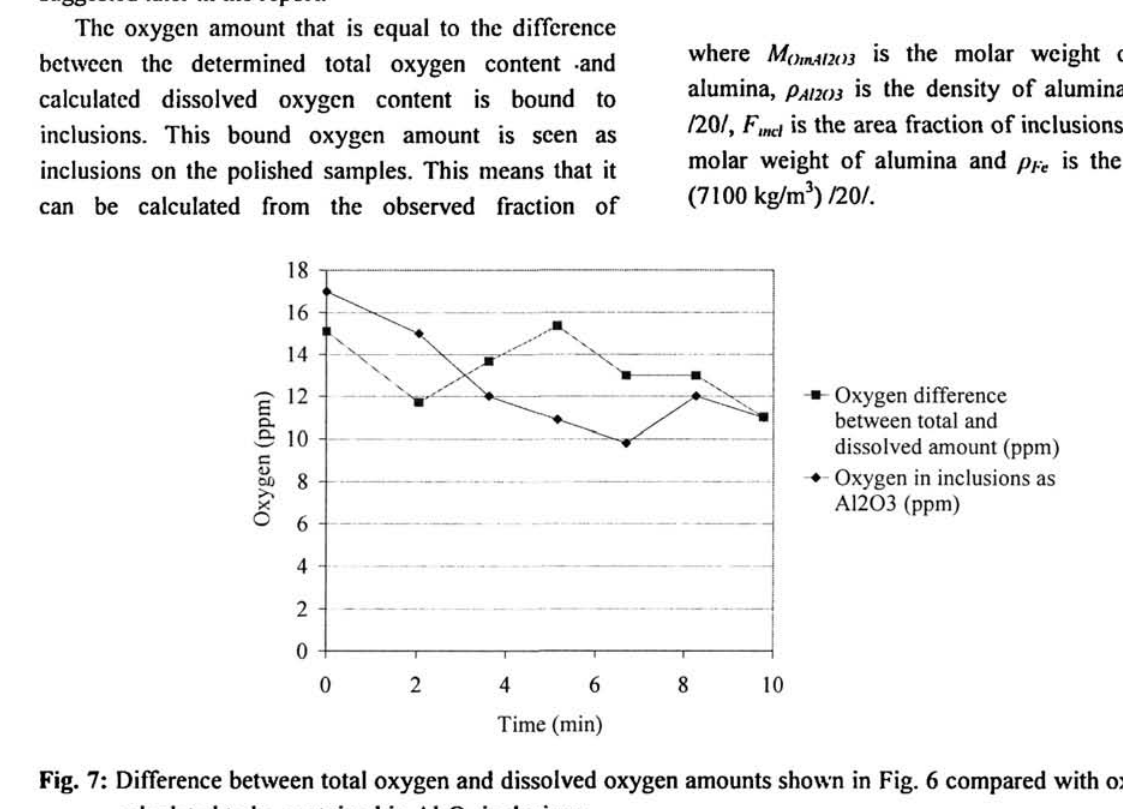
Fig. 7: Difference between total oxygen and dissolved oxygen amounts shown in Fig. 6 compared with oxygen amount calculated to be contained in A1 O 2 3